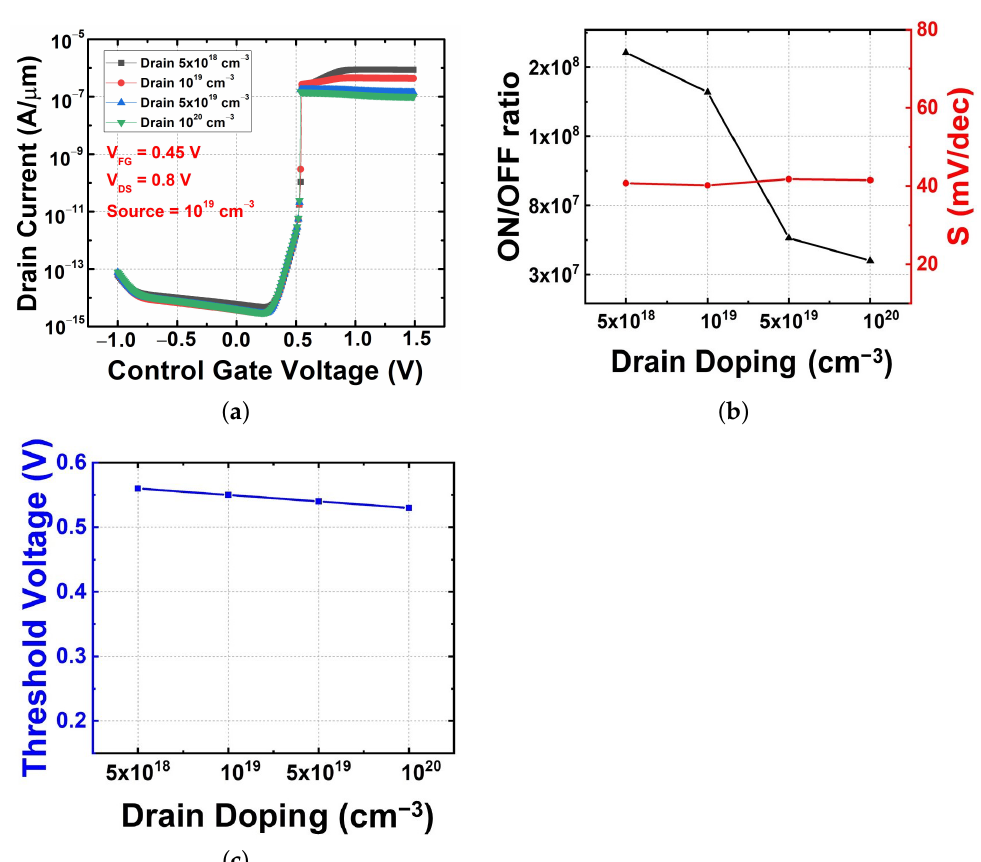
Figure 6. Electrical characteristics with drain doping variations. ( a ) Transfer characteristics, ( b ) on–off current ratio and subthreshold swing, and ( c ) threshold